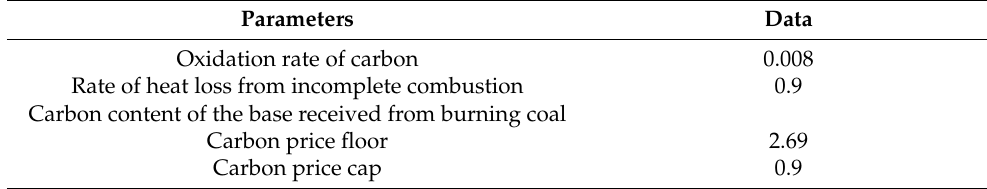
Table 6. Parameters related to carbon emissions market.